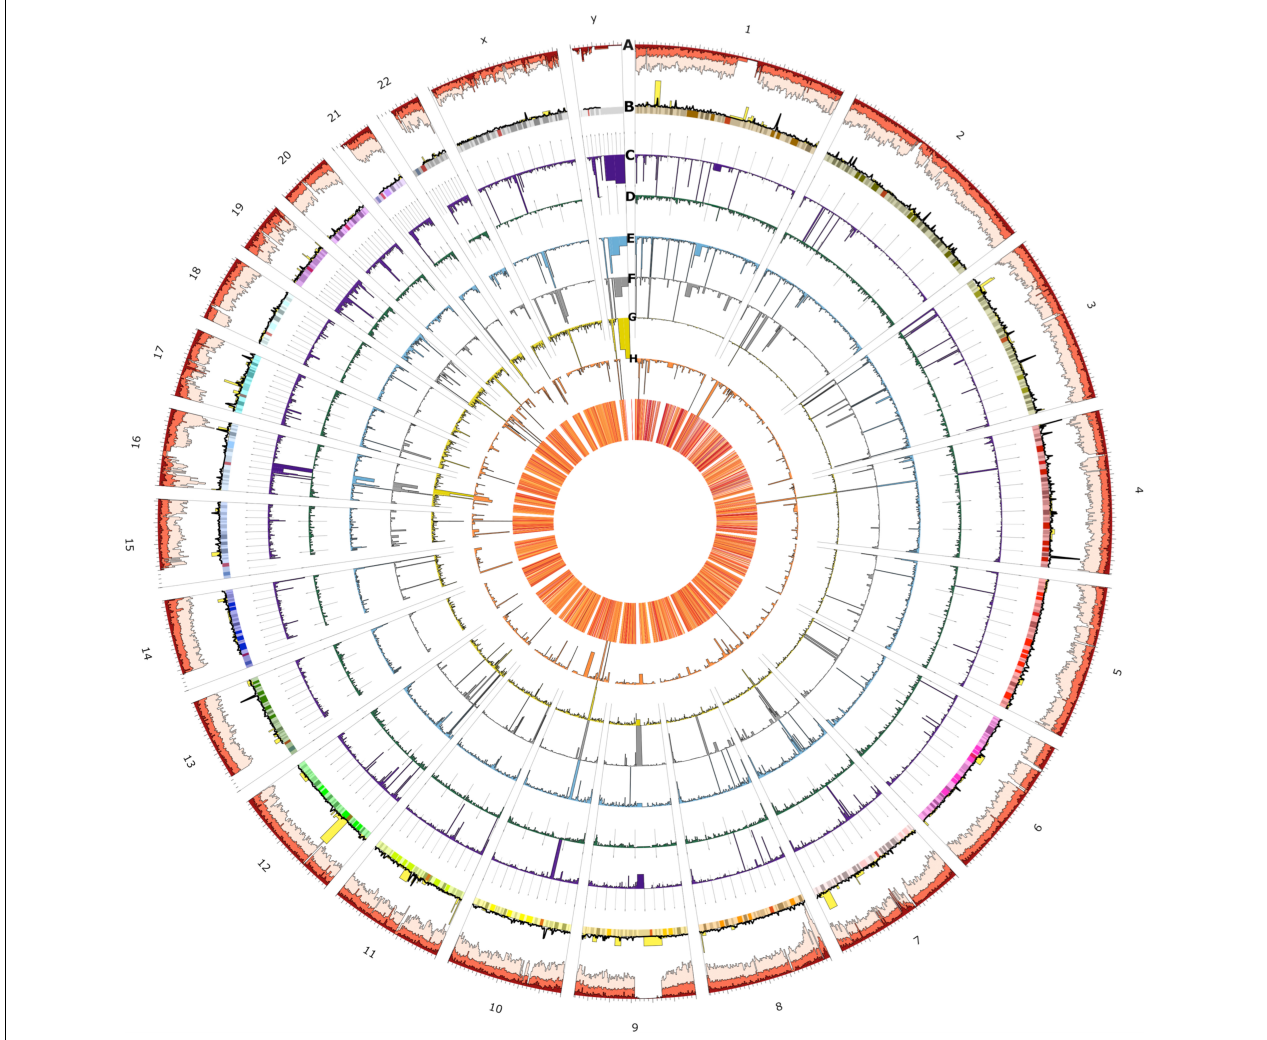
FIGURE 4 | Circos plot of the spatial distribution of short variants and structural variants (SVs) across all chromosomes (outer ring). From outer to the inner rings: (A) short variants called from the 153 UAE samples (light red), novel (red), and novel UAE population-specific (dark red) variations which indicate regional variability characteristics (note that scales are modified for visibility), (B) loss of function (yellow) and UAE population specific variants (black line), (C) SVs consensus set (dark purple), of which the (D) through (G) rings show insertions (dark green), deletions (blue), duplications (gray), translocation (dark yellow), and inversions (orange), respectively. The heatmap in the innermost plot of the figure displays the frequency of